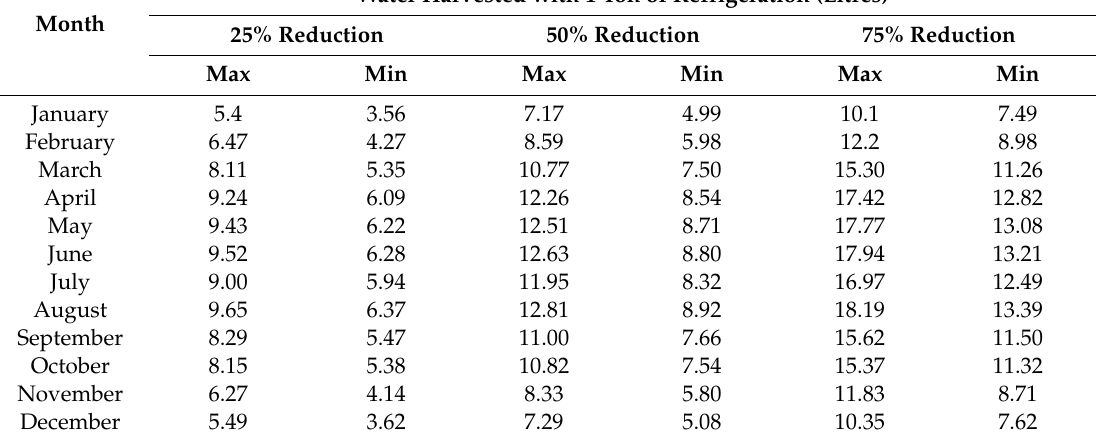
compressor with 1 ton of refrigeration